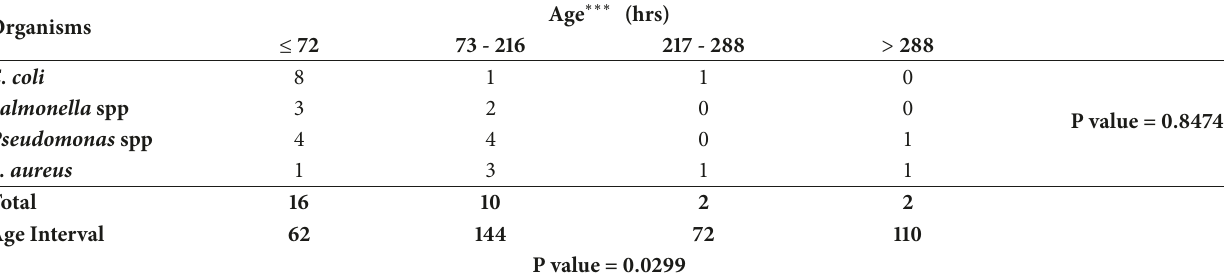
Table 2: Frequency of occurrence of the